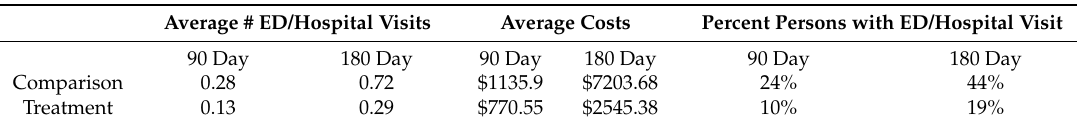
ED/Hospital Visit Rate and Average Visit Costs per Patient, Comparison versus Treatment Groups.